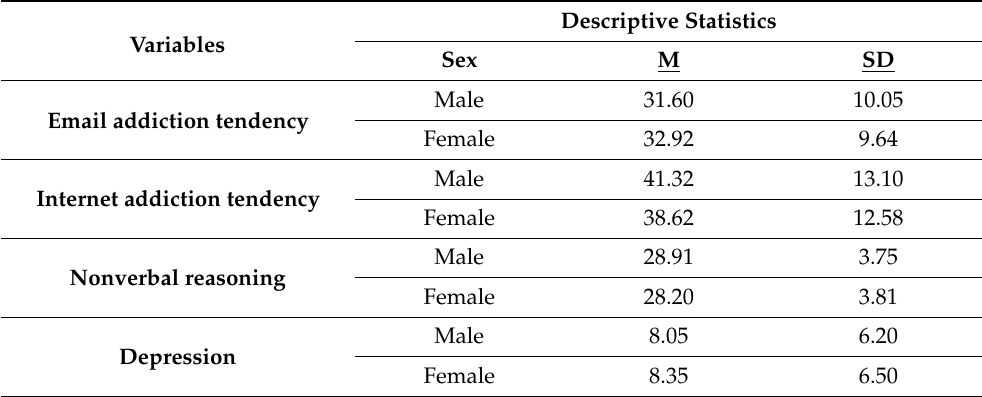
Table 1. Characteristics of the psychological variables of the